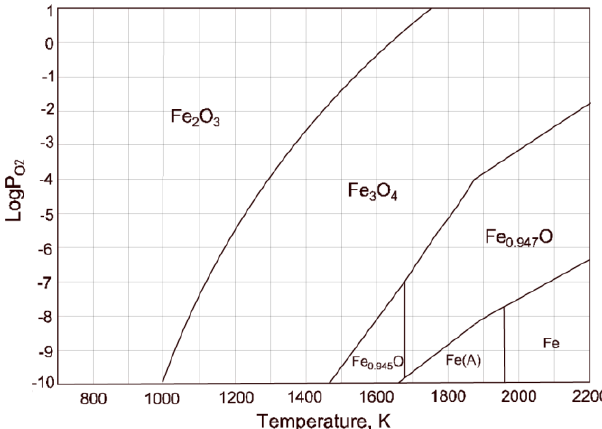
Figure 8. Predominance diagram for the Fe-O system at high temperatures constructed with HSC® software. The sections delimited by the continuous lines, represent the conditions at which the described species are thermodynamically stable.